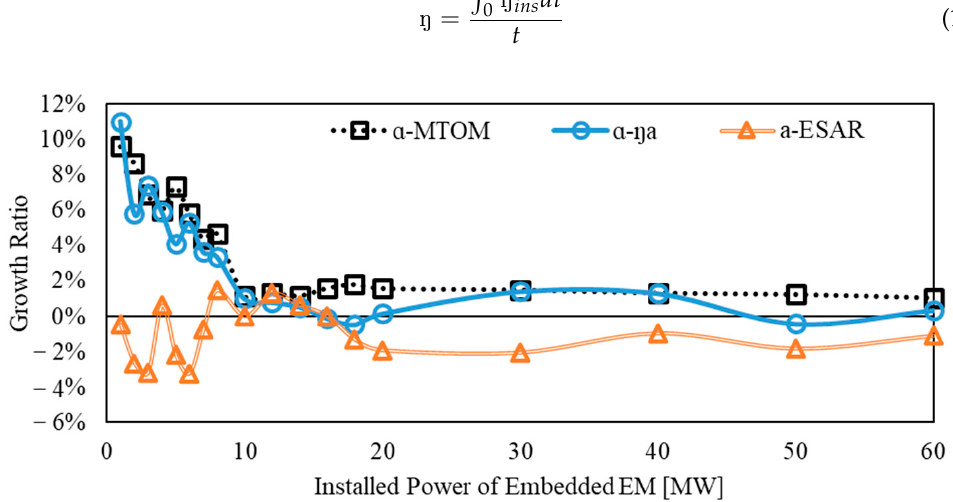
Figure 8. Comparison between MTOM, average efficiency and ESAR in terms of their growth ra- tios.